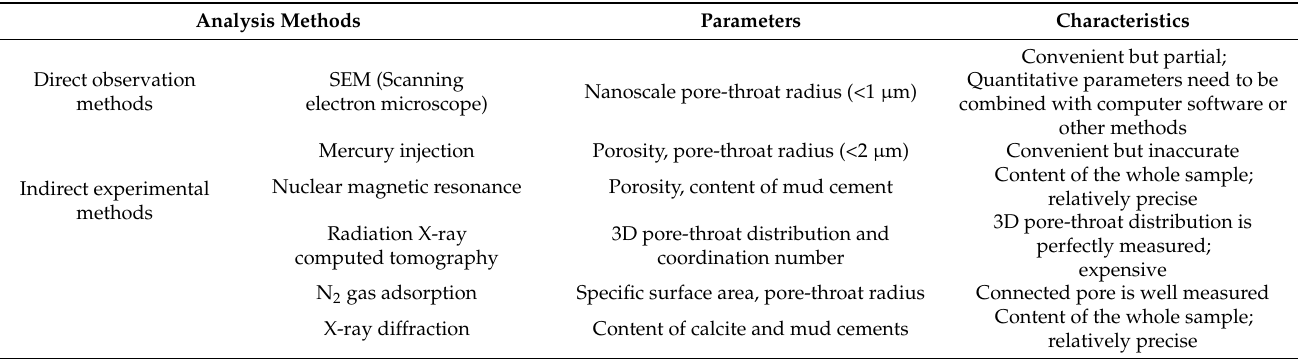
Table 1. Quantitative analysis methods for pore throat parameters of